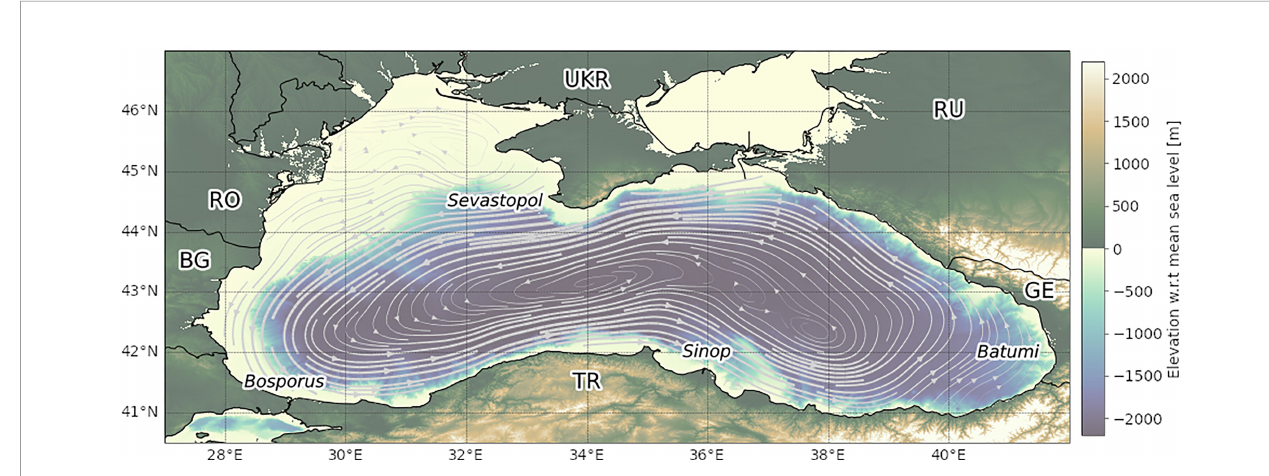
FIGURE 1 | Elevation and bathymetry of the Black Sea region. Average circulation is obtained from (Jousset et al., 2021) and depicts the large scale cyclonic Rim current. Regional labels used in the manuscript are given in italic. Large labels are for riparian countries: UKR, Ukraine; RU, Russian Federation; GE, Georgia; TR, Turkey; BG, Bulgaria; RO,